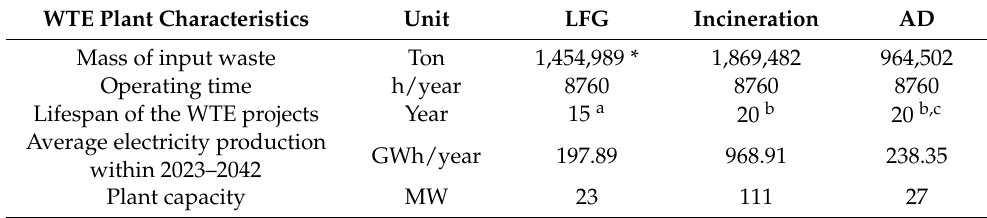
Table 6. Energy and power